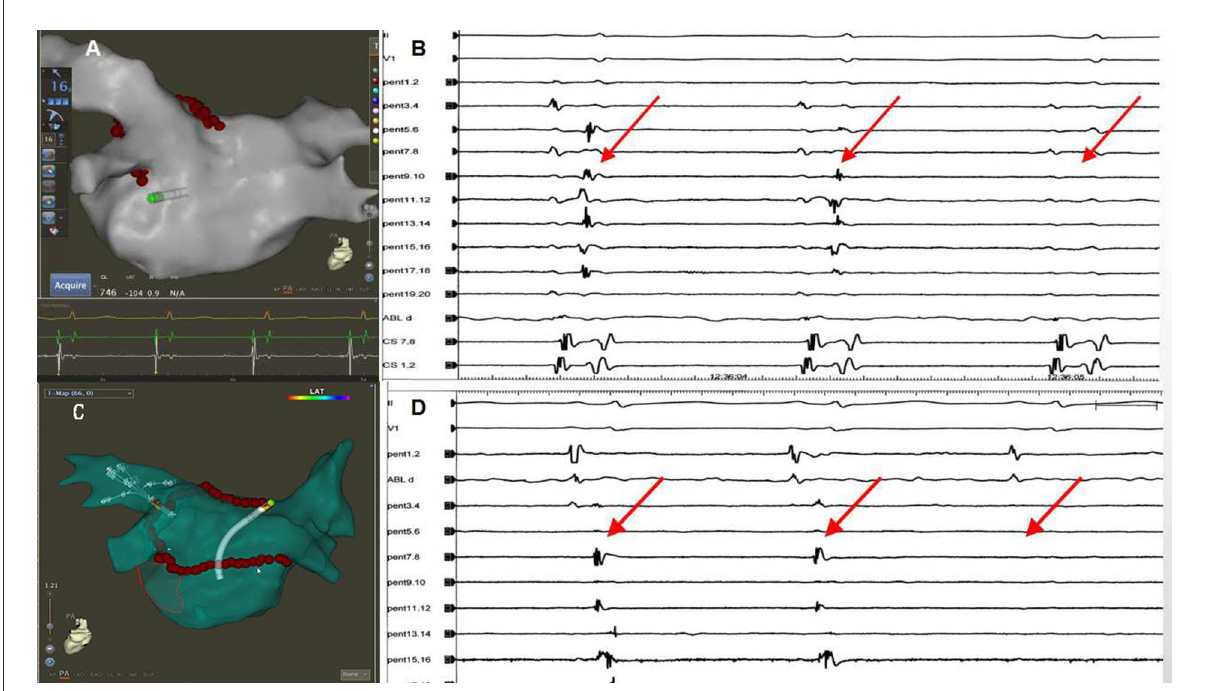
FIGURE5 The left PV isolation was achieved with ablation line sparing. (A) The left PV isolation was achieved after the ridge and roof lines were completed. (B) The elimination of the left PV potential (red arrow) when the ridge line and the left PV roof lines were completed. (C) The superior and inferior left PVs were isolated when ablating at the roof near the right superior PV after the left ridge line and the inferior line were completed. (D) The elimination of the left PV potentials (red arrow) when ablating at the roof near the right superior PV.